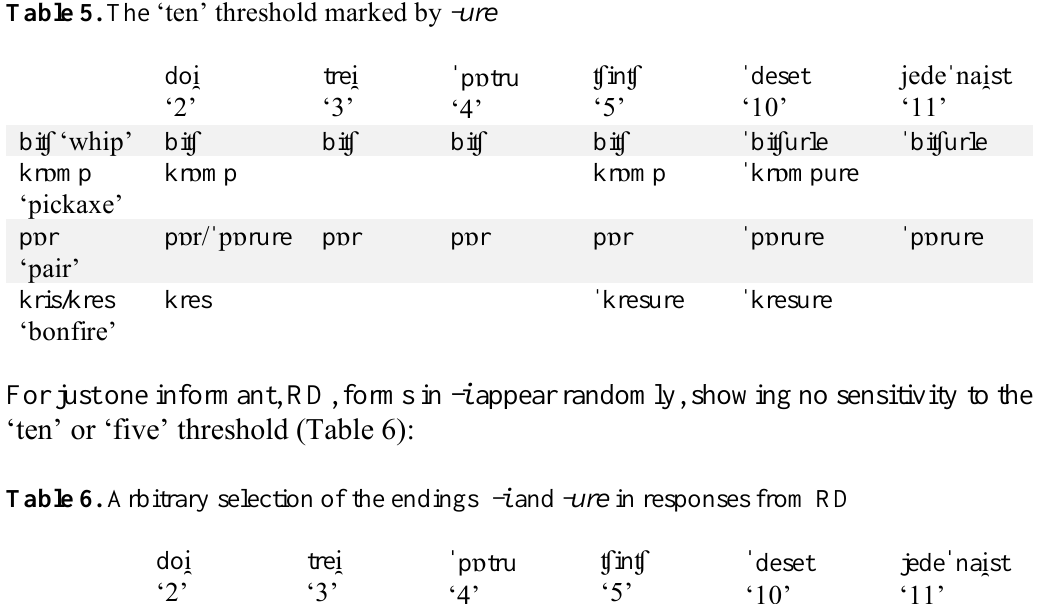
Table 5. The ‘ten’ threshold marked by -ure